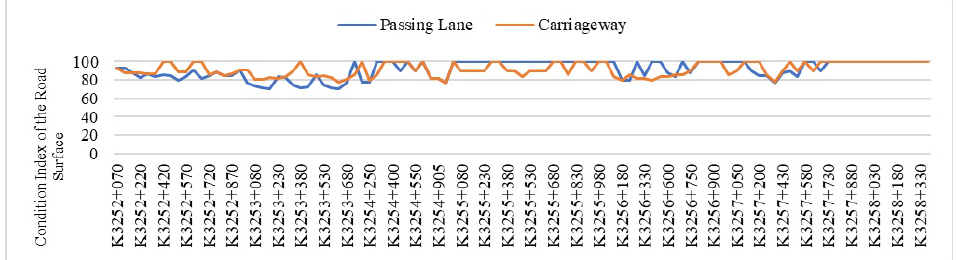
Fig. 2 Index distribution of the condition of road surface damage in K3139 + 200 ∼ K3202 + 500